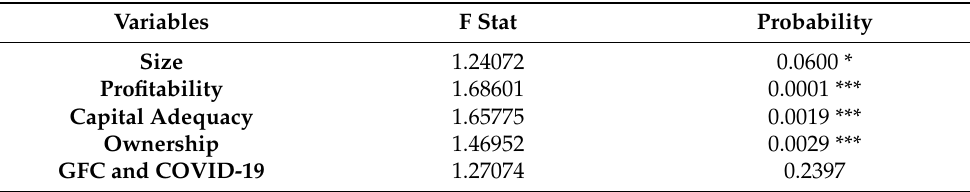
Table 5. Hypothesis testing for competition network Index. Variables F